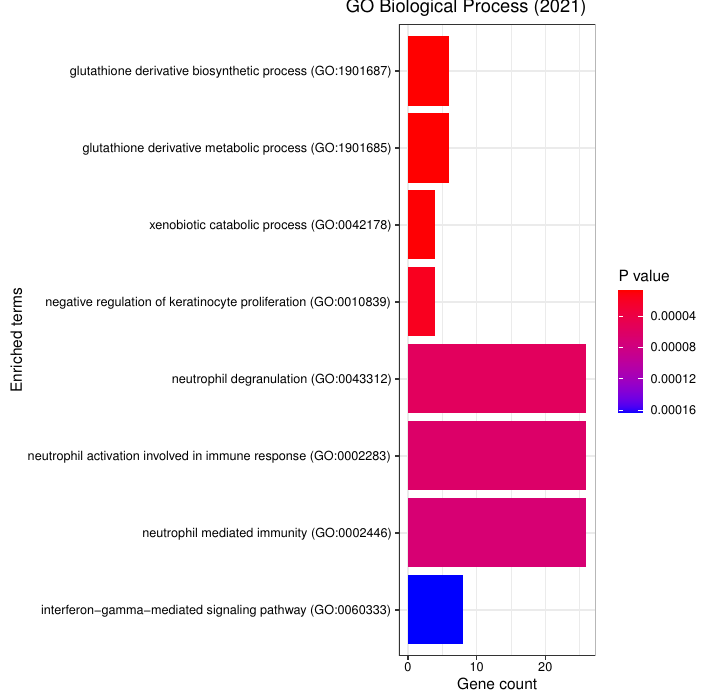
Figure 5. List of all the GO Biological Processes that are enriched in the selected genes, with the respective number of genes belonging to each term. The analysis was performed with enrichR at an FDR <